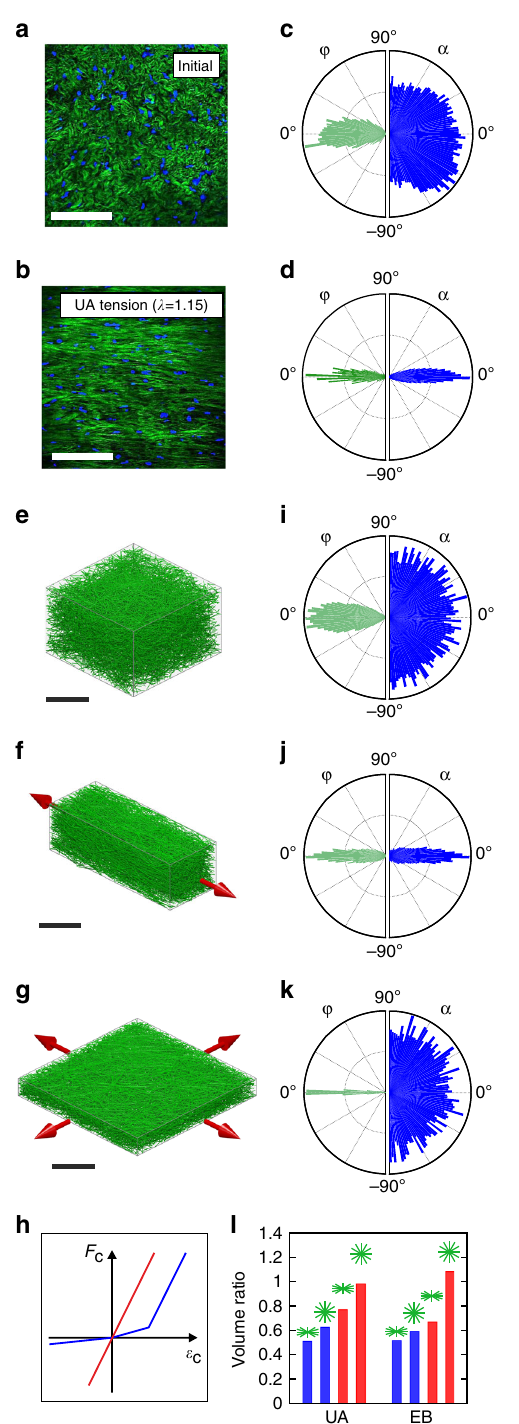
Fig. 3 Kinematics of collagen fi ber networks. a , b Multiphoton Microscopy (MPM) images of bovine Glisson ’ s capsule (bGC) in initial ( a ) and ( b ) deformed con fi guration (uniaxial (UA) elongation of ~15%, i.e. λ 1 ≈ 1.15); Second harmonic generation (SHG) signal ( green ) and fl uorescence of stained cell nuclei ( blue ). Scale bar : 100 μ m. c , d Out-of-plane ( green, left ) and in-plane ( blue , right ) fi ber orientation distribution measured in a representative bGC sample under the same conditions as for a , b . e – g Visualization of the 3D discrete network model mechanically equivalent to bGC, in initial and deformed con fi guration under UA and equibiaxial (EB) tension at λ 1 = 1.15 (loading directions marked by red arrows ). Scale bar : 100 μ m. h Qualitative axial force vs. strain diagram of linear ( red ) and nonlinear ( blue ) fi ber response. i – k Computed out-of-plane ( green ) and in-plane ( blue ) orientation distributions corresponding to e – g . l Volume ratios with respect to reference con fi guration at λ 1 = 1.15, computed for different network types, with either initially oriented or isotropic fi ber distribution in out-of-plane direction ( green symbol ), and either nonlinear ( blue ) or linear ( red ) fi ber